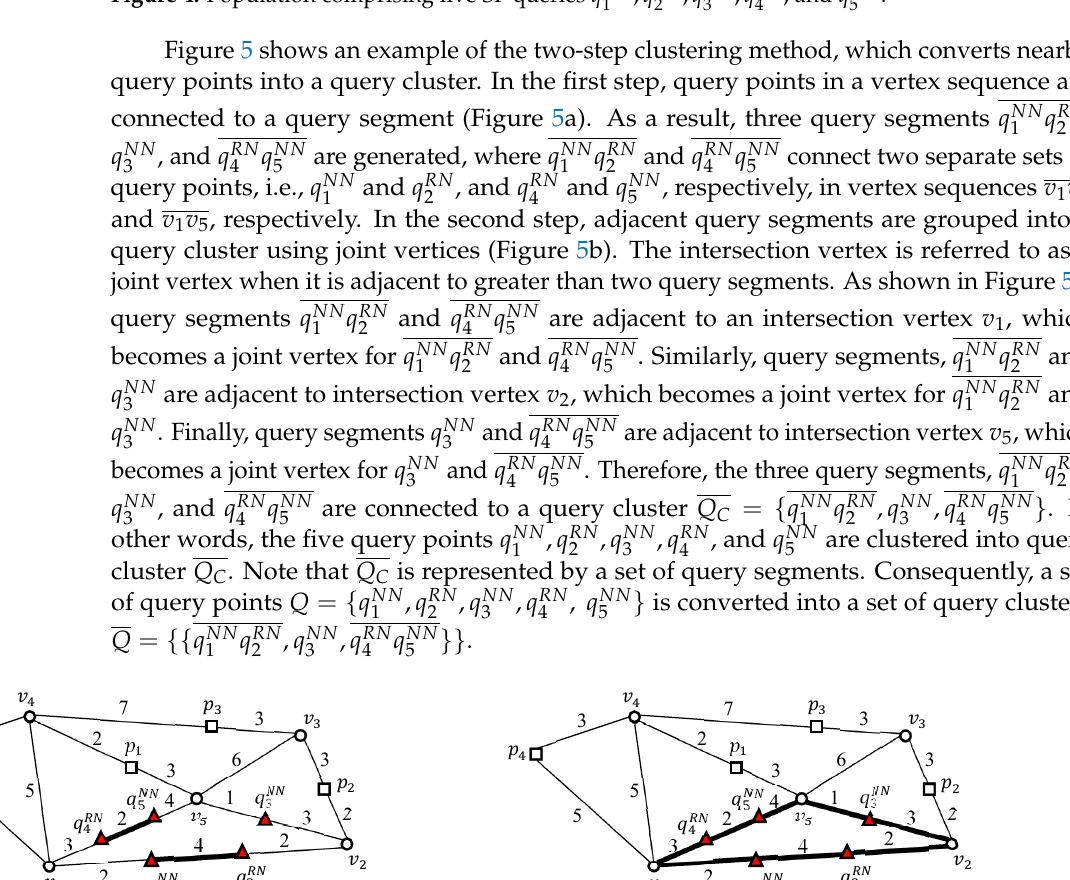
Figure 4. Population comprising five SP queries q NN